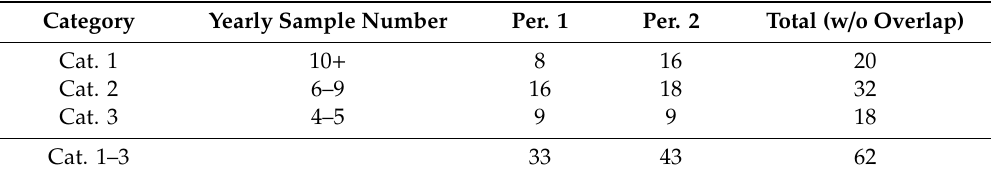
Table 3. The number of monitoring stations per uncertainty category and model period. Per. 1: 2009–2012; Per. 2: